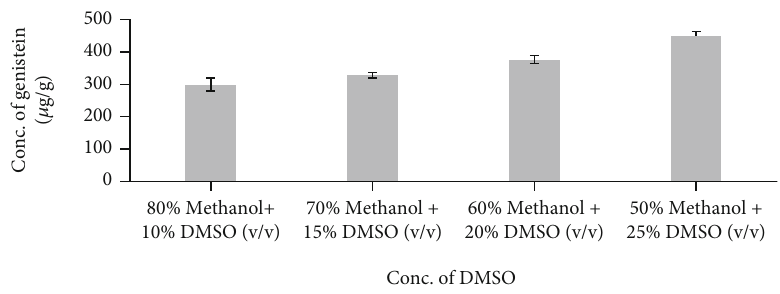
Figure 5: In fl uence of di ff erent concentration of DMSO on Cuminum cyminum genistein content. (100mL of solvent (Methanol + DMSO), temperature 80 ° C and time 1 h). (The bars show the mean values from three replicates ( n = 3 ) with the respective standard